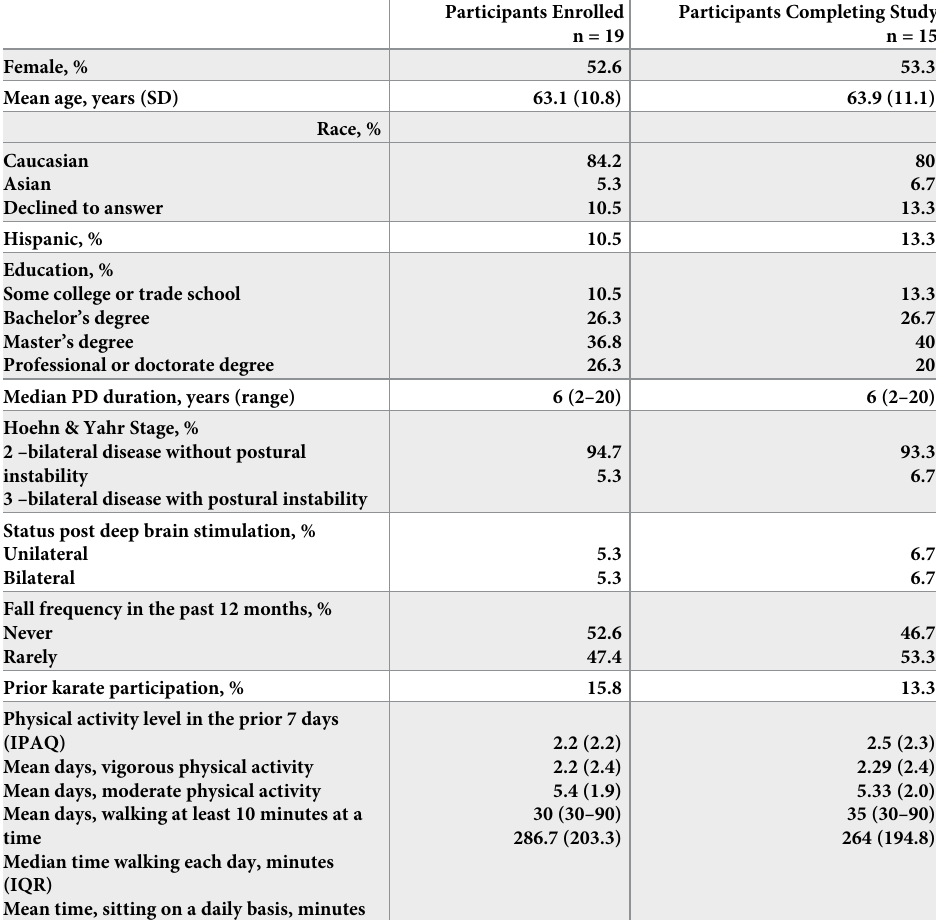
Table 1. Baseline characteristics of KICK OUT PD